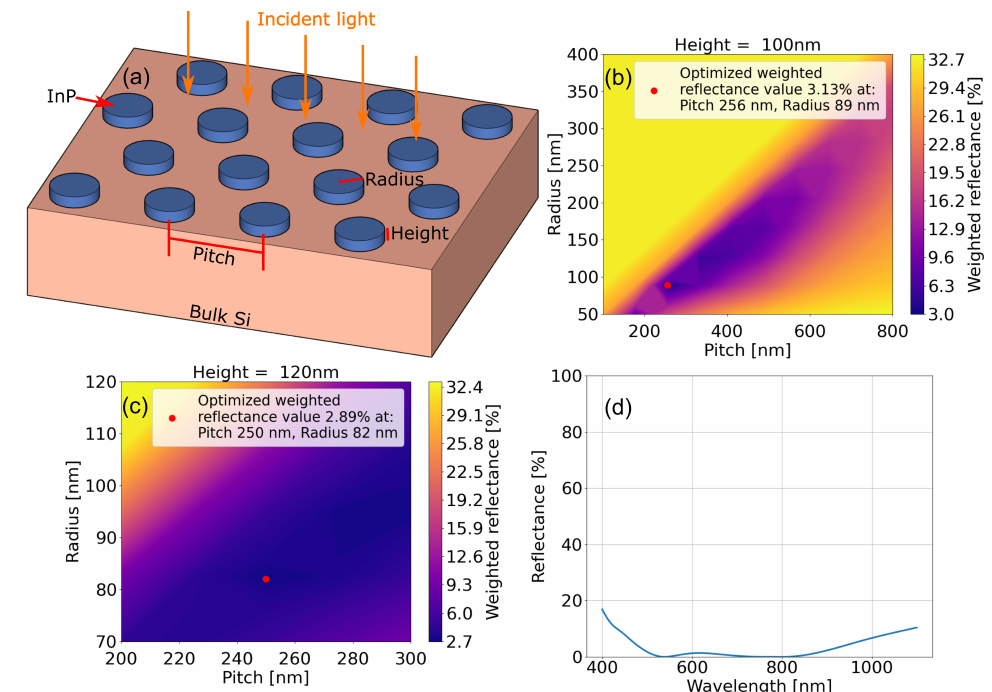
Figure 2. Optimization of weighted reflectance of InP nanodisks on a Si substrate. ( a ) Schematic of the structure with relevant array parameters pitch, height, and radius. The incident light is depicted in yellow. A rough optimization shown in ( b ) and the final optimized reflectance and nanodisk array parameters shown in ( c ). All parameters were varied in the sweeps but only the results from the optimized heights are shown. ( d ) Reflectance of the optimized InP nanodisk/Si